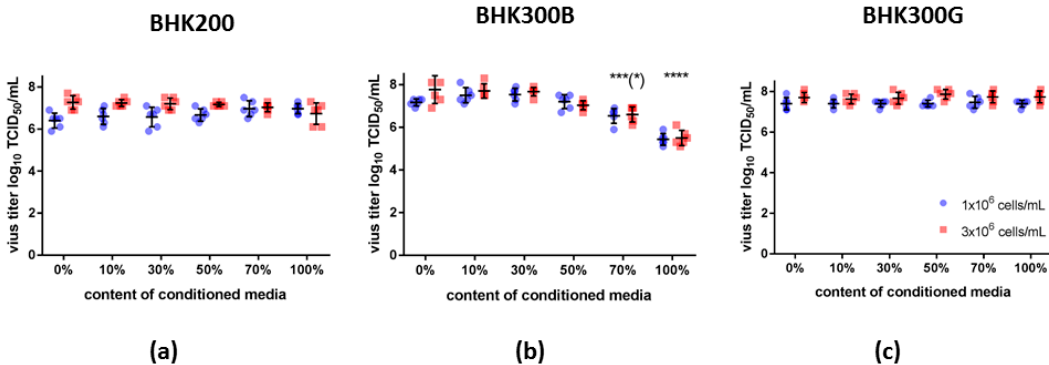
Figure 3. Virus growth in cell culture media with different contents of conditioned media in spin tubes. Cells were grown in the ( a ) ACF media BHK200 and in the chemically defined media (CDM) ( b ) BHK300B and ( c ) BHK300G in two different cell densities (1 × 10 6 cells/mL: blue; 3 × 10 6 cells/mL: red). Different percentages of 0%, 10%, 30%, 50%, 70% and 100% conditioned media were applied before viral infection with FMDV O/SAU/18/2015 at a MOI of 0.01. Significance code: “****” p ≤ 0.0001, “***” p ≤ 0.001.